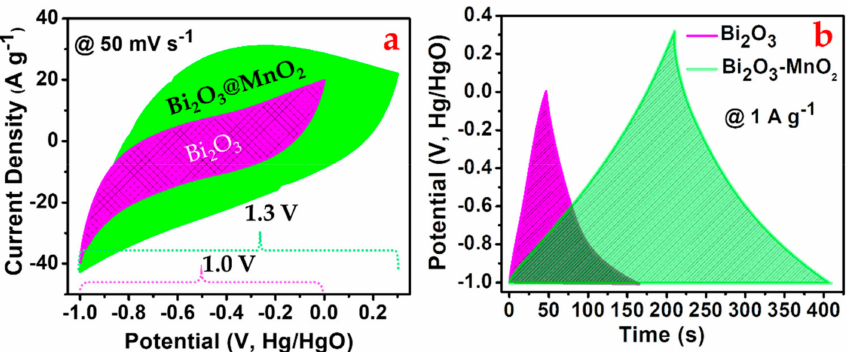
Figure 4. ( a ) Cyclic voltammetry (CV) and ( b ) galvanostatic charge–discharge (GCD) comparison of Bi 2 O 3 and Bi 2 O 3 -MnO 2 ES